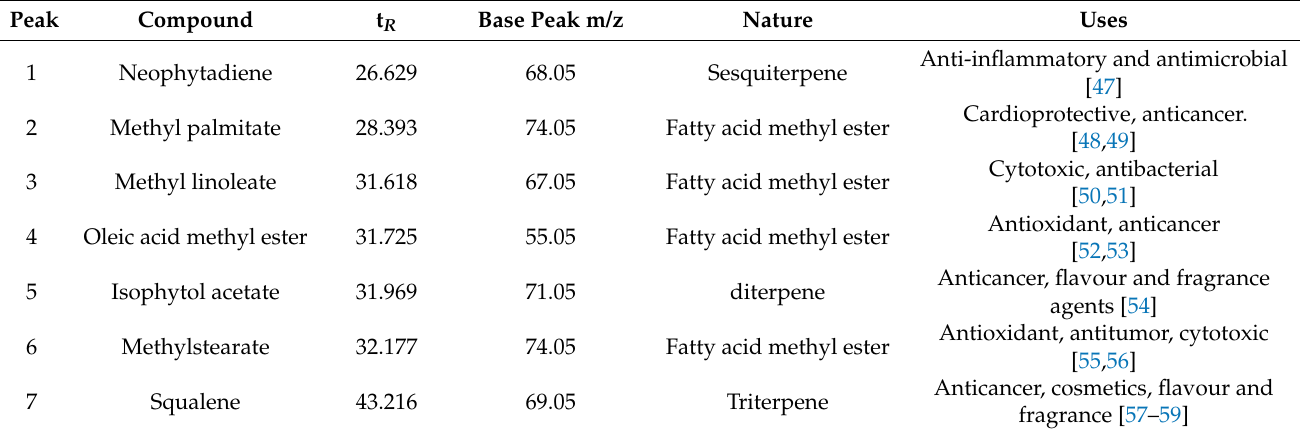
Table 5. GC-MS identified compounds present in methanol extract of C. colocynthis